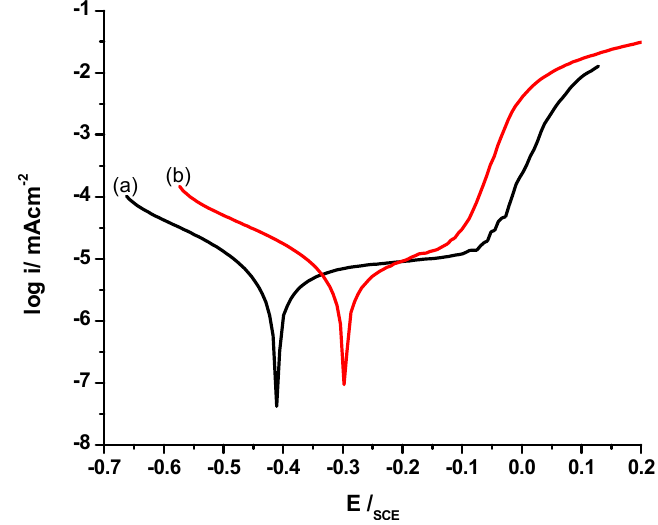
Figure 13. Tafel plot of (a) uncoated and, (b) PANI coated stainless steel.